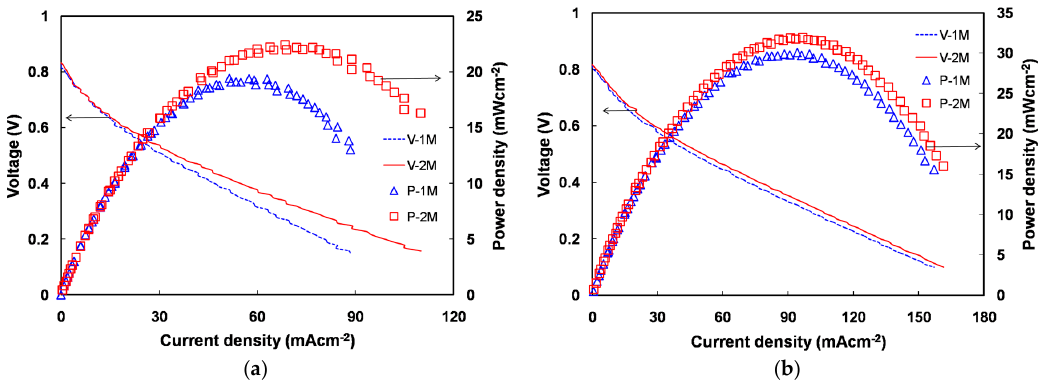
Figure 5. DMAFC performance with different methanol concentrations in 6 M KOH at 60 °C using ( a ) CL-QPVA membrane; ( b ) CL-QPVA/GO-Fe 3 O 4 composite prepared without the magnetic field. Cathode: humidified oxygen with a flow rate of 100 mL·min − 1 . GDEs: catalysts of 6 mg·cm − 2 Pt-Ru/C for anode and 5 mg·cm − 2 Pt/C for cathode on MPL-free carbon cloth.